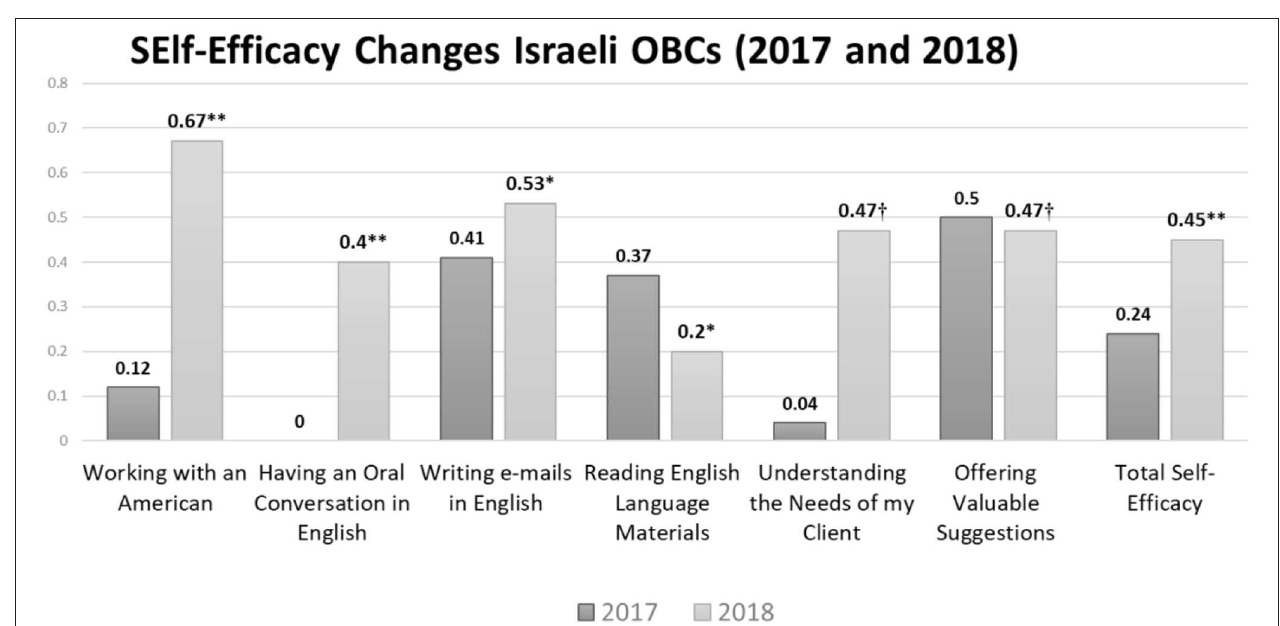
FIGURE 4 | Israeli students self-efficacy changes for 2017 (Year 1) and 2018 (Year 2). * p < 0.05; ** p < 0.01; † p <